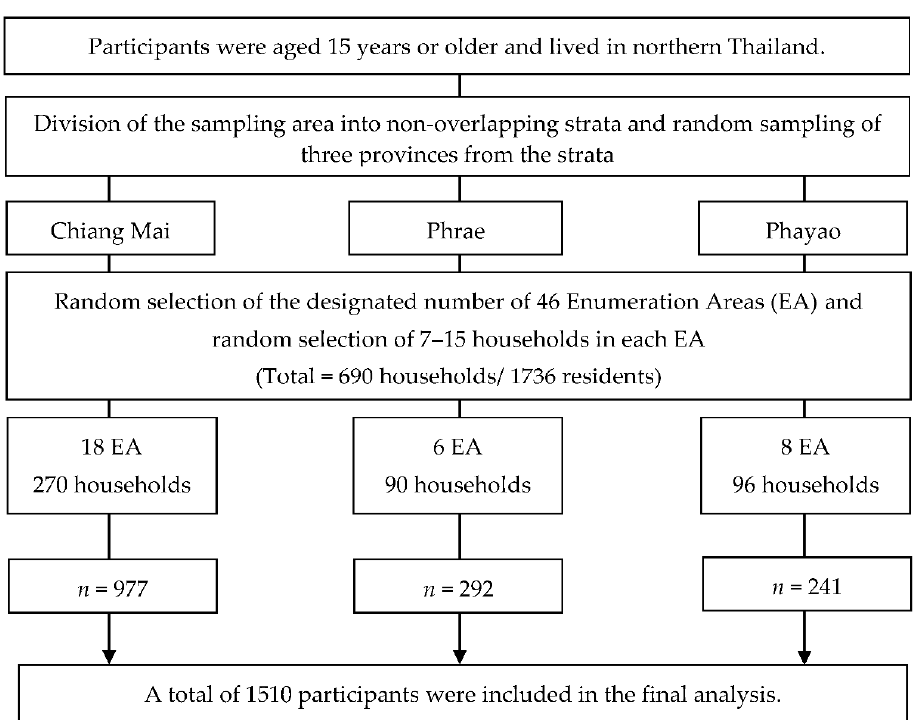
Figure 1. Flow diagram of the recruitment of sampled participation into this study.